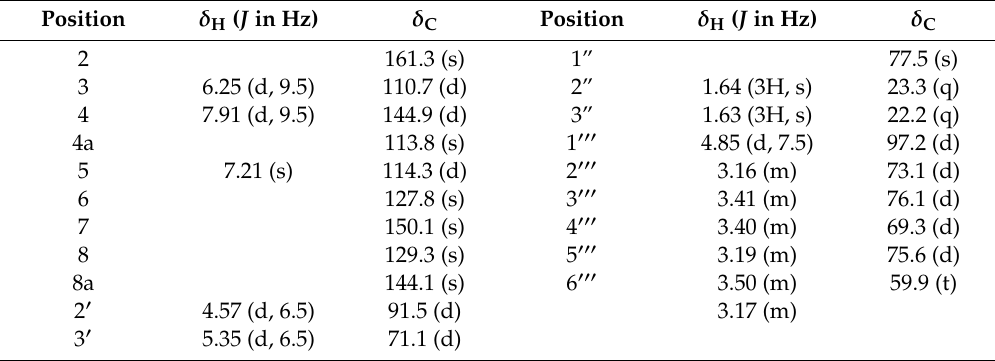
Table 2. 1 H NMR (400 MHz, MeOD) and 13 C NMR (101 MHz, MeOD) spectroscopic data of 6 . Position δ H ( J in Hz) δ C